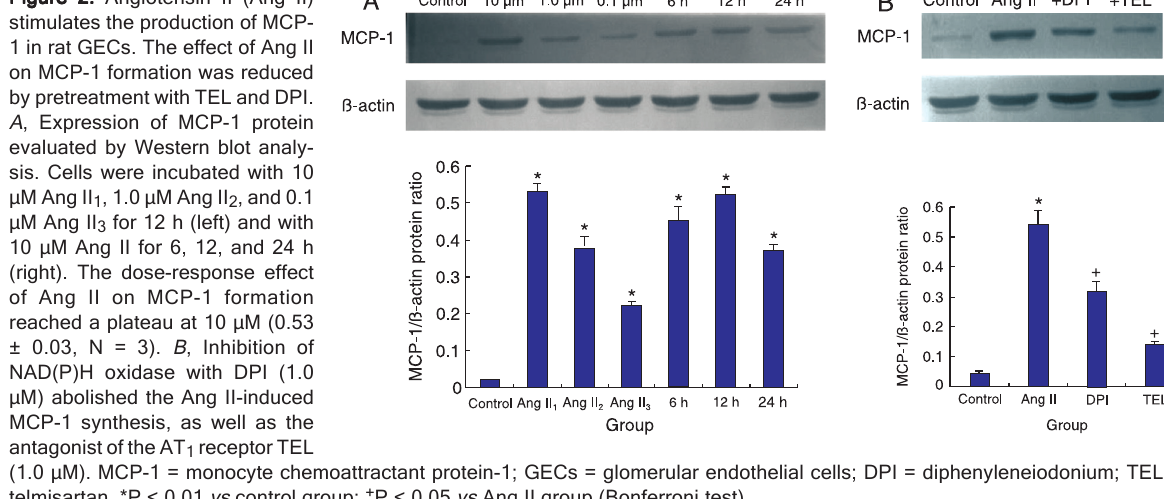
Figure 2. Angiotensin II (Ang II) stimulates the production of MCP- 1 in rat GECs. The effect of Ang II on MCP-1 formation was reduced by pretreatment with TEL and